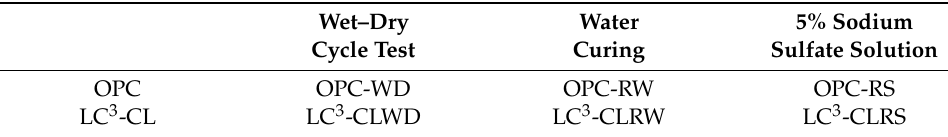
Table 2. Labeling of the samples subjected to sulfate